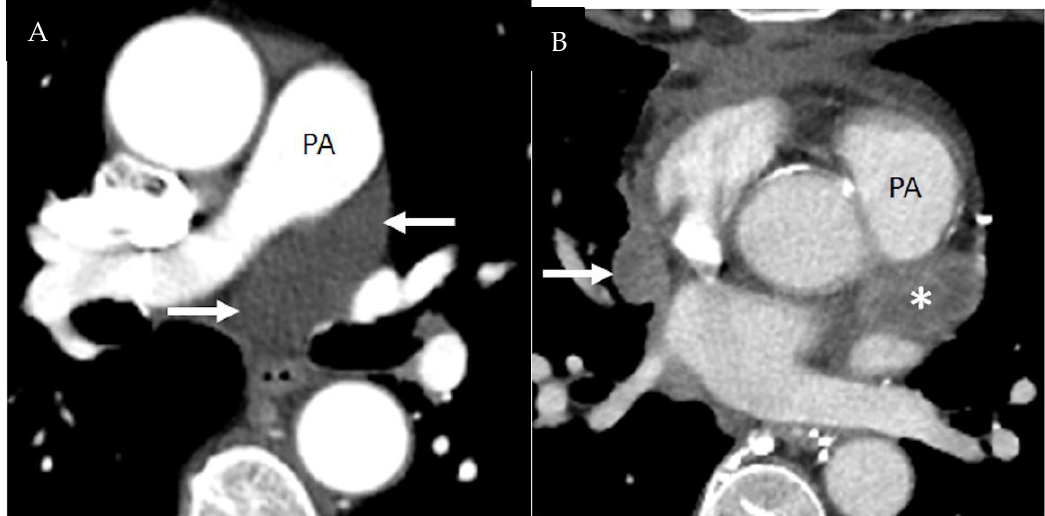
Figure 5. Fluid versus metastatic disease in the left pulmonic recess. ( A ) 63 year-old woman with rectal cancer. Contrast-enhanced axial CT at the level of the main pulmonary artery shows fluid distending the left pulmonic recess (arrows). The left pulmonic recess is usually seen as a spindle- shaped or crescentic fluid attenuation structure located immediately adjacent to the posterior wall of the proximal right pulmonary artery. ( B ) 56 year-old man with thymoma. Contrast-enhanced axial CT at the level of the main pulmonary artery shows heterogeneously enhancing soft tissue representing pericardial metastatic disease (*) in the left pulmonic recess. Arrow denotes additional pericardial metastasis along the right heart. Soft tissue attenuation and enhancement help distinguish adenopathy or metastatic disease from recess fluid. PA = pulmonary artery. Reprinted from Shroff G.S. et al. Pitfalls in oncologic imaging of the pericardium on CT and PET/CT